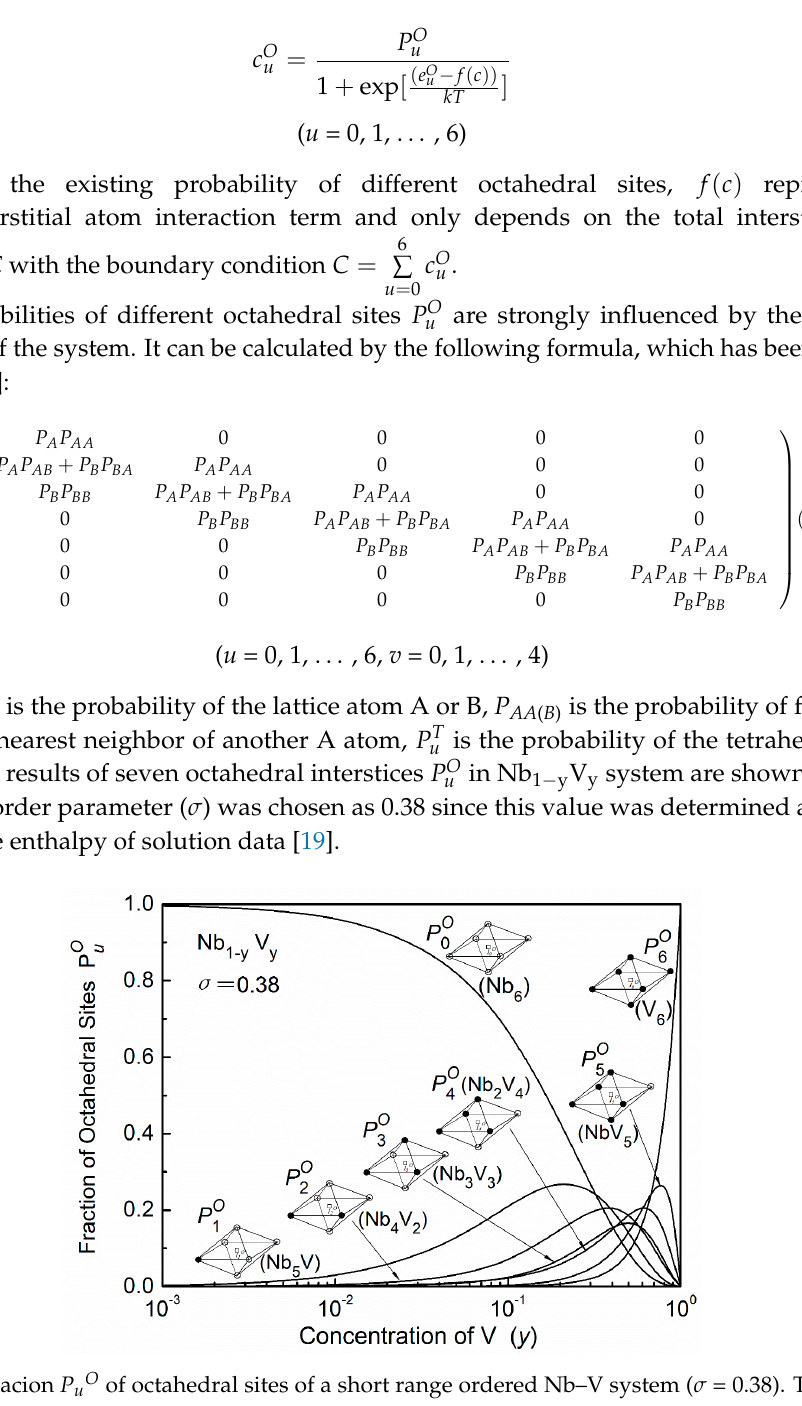
—Nb atoms, (cid:35)